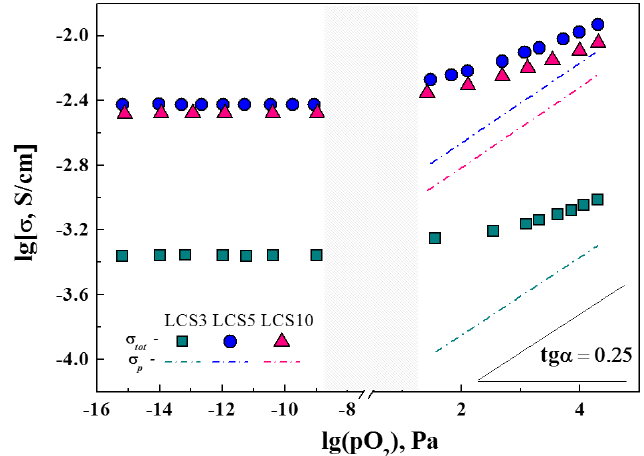
Figure 8. Dependences of conductivity of LCS samples on the oxygen partial pressure at 700 °C and p H 2 O = 4.5 kPa. Dashed lines are the hole conductivity of LCS.